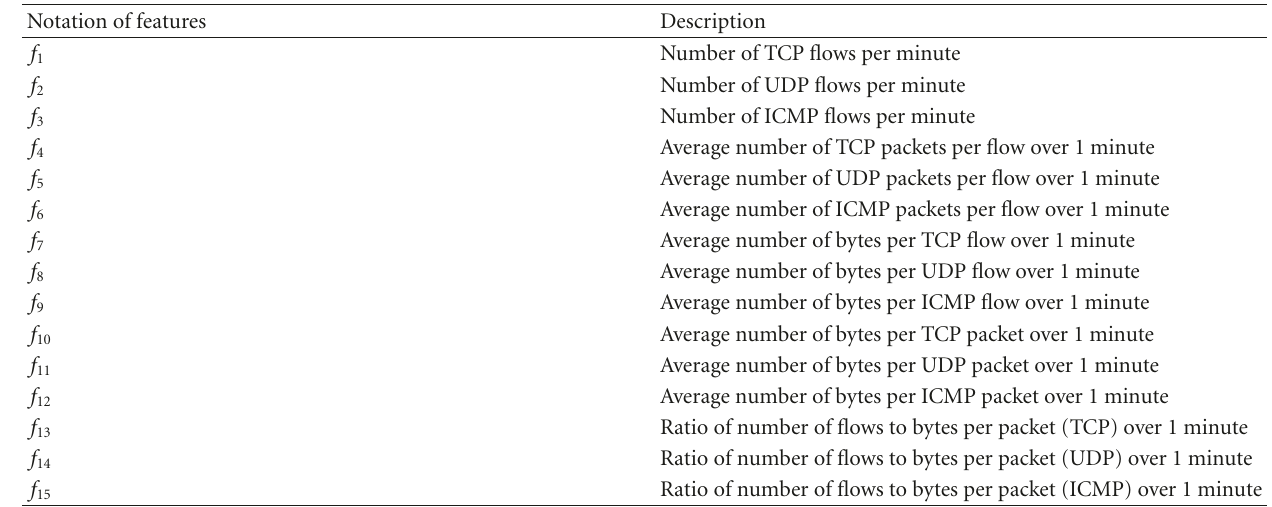
Table 1: List of